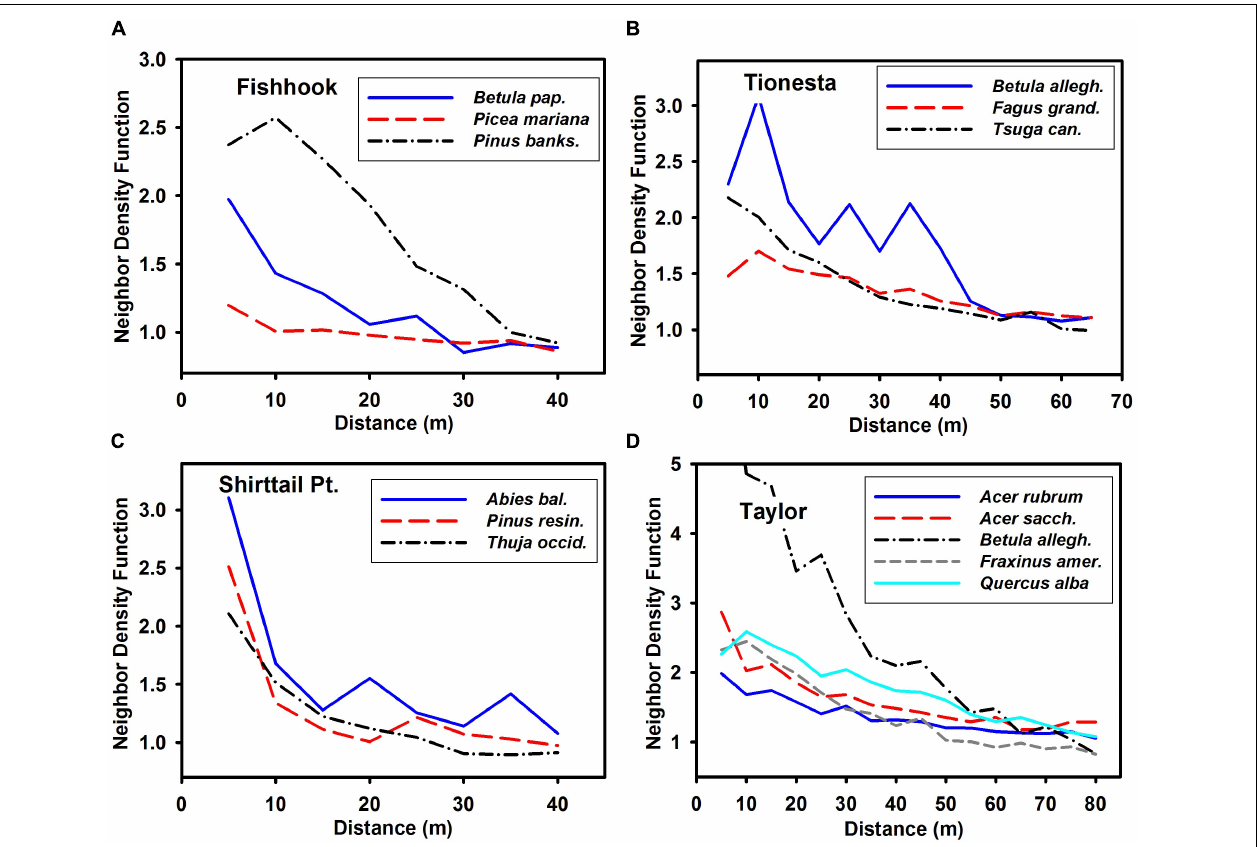
FIGURE 2 | Neighbor density function of major ( n > 40) species in pre-disturbance stands at the four sites. (A) Fishhook; (B) Tionesta; (C) Shirttail; and (D) Taylor. Note that x and y axes differ among the panels in this figure. Confidence intervals omitted for clarity; a value of unity on the y axis corresponds to complete spatial randomness. Values greater than unity are more aggregated than random; values less than unity are more uniform than random. Species abbreviations as follows: Betula pap. , Betula papyrifera ; Pinus banks ., Pinus banksiana ; Betula allegh ., Betula alleghaniensis ; Fagus grand. , Fagus grandifolia ; Tsuga can ., Tsuga canadensis ; Abies bal ., Abies balsamea ; Pinus res. , Pinus resinosa ; Thuja occid ., Thuja occidentalis ; Acer sacch ., Acer saccharum ; and Fraxinus amer ., Fraxinus americana .